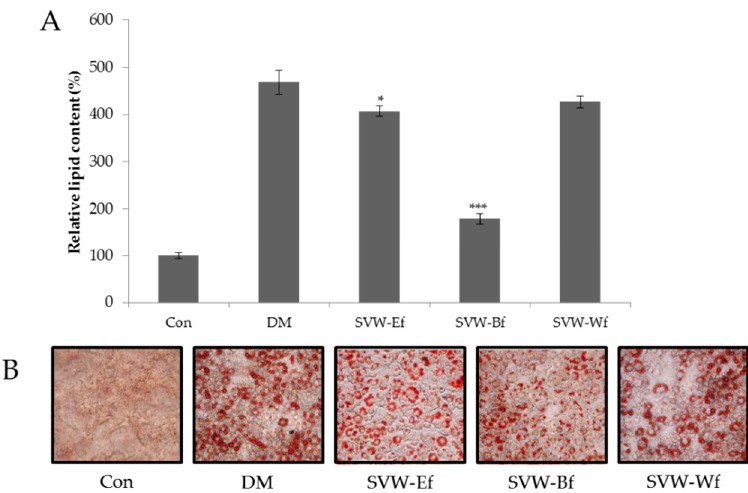
Figure 2. Effect of SVW solvent fractions on inhibition of 3T3-L1 adipocyte differentiation. ( A ) The relative lipid content; ( B ) Oil Red O staining images. Confluent 3T3-L1 preadipocyte were differentiated into adipocytes in medium with or without 10 μ g/mL of SVW fractions for 8 day. Con is control group; DM is differentiation media cells; SVW-Ef is ethyl acetate fraction from S. virgaurea var. gigantea water extract; SVW-Bf is n -butanol fraction from S. virgaurea var. gigante water extract; SVW-Wf is water fraction from S. virgaurea var. gigantea water extract. Three independent experiments have been carried out; * p < 0.05 vs. DM; *** p < 0.005 vs. DM.